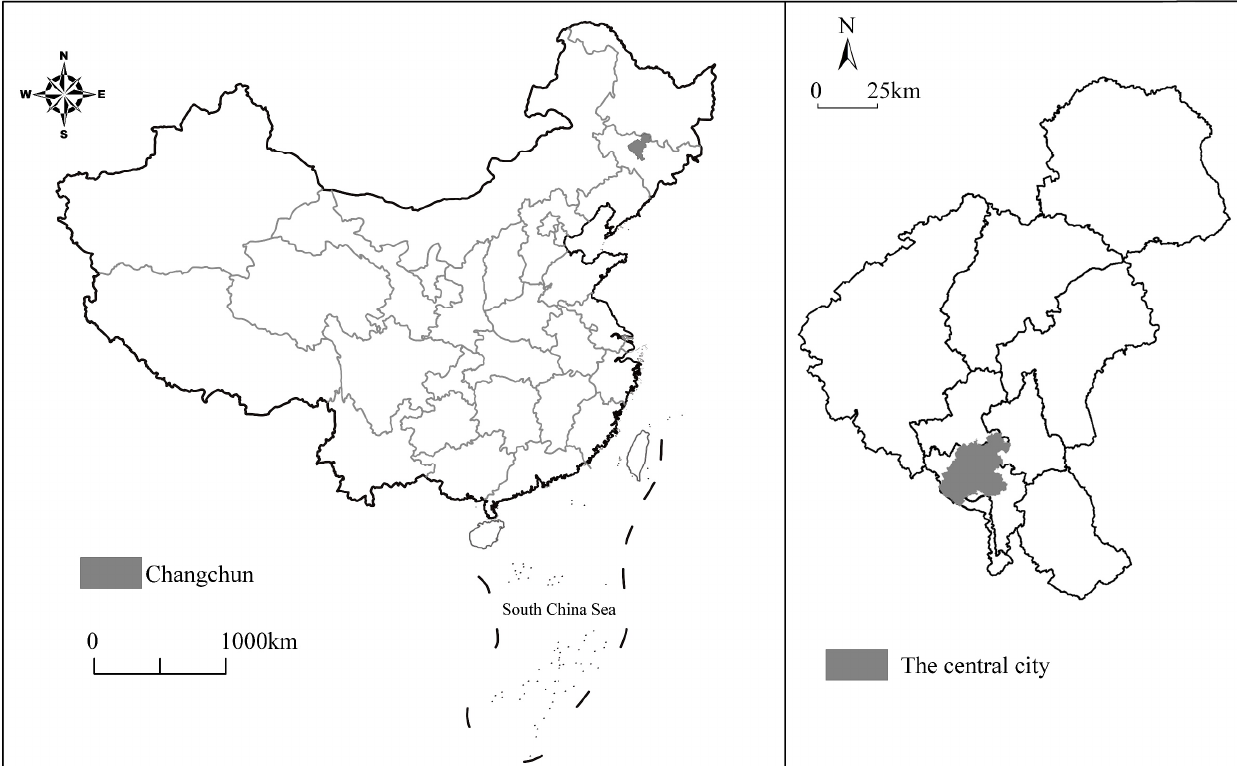
Figure 1. Location of study